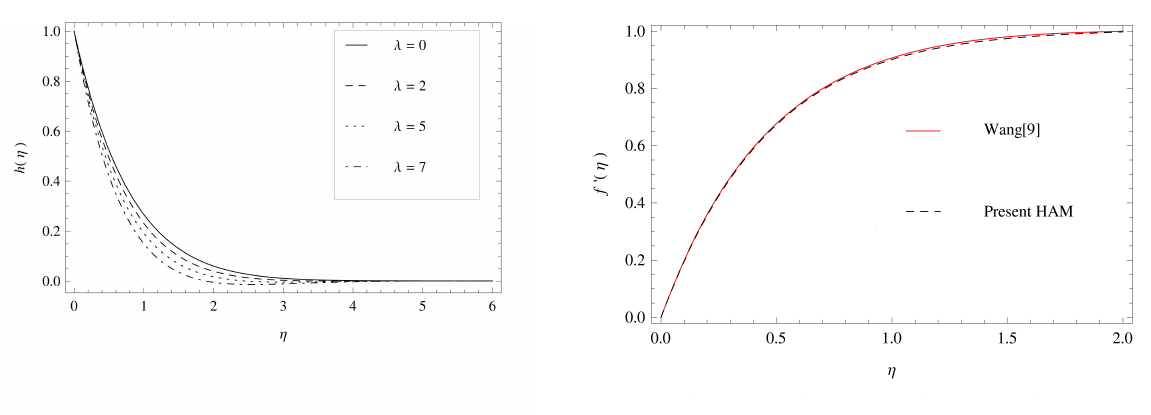
Fig. 18: The influence of a parameter We on h ( η ) for λ = 0.1, α = 3, M = 0.6, f = 0.5 and (cid:126) = −0.1 w